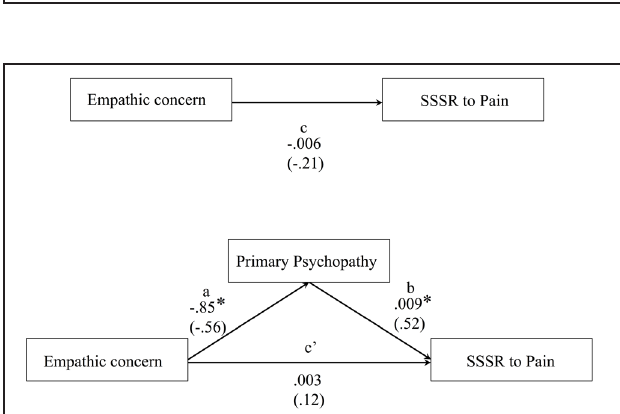
FIGURE 7 | Illustration of the direct effects of the bootstrap mediating model predicting SG to pain observation ( N = 30) using the 5000 bootstrap samples. Path values represent both unstandardized regression coefficients (bold) and standardized regression coefficients (in brackets). ∗ p < 0 .